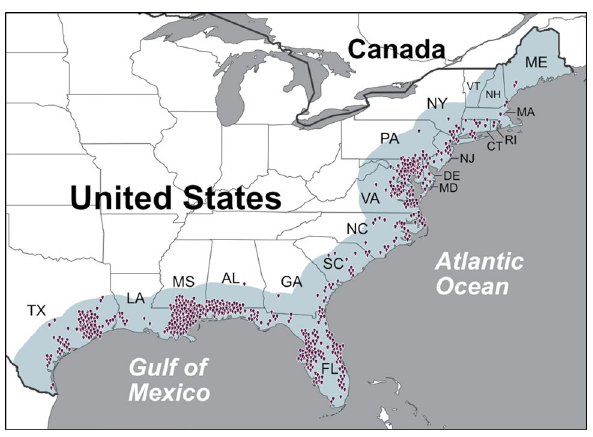
Figure 1. Original locations of the 709 confirmed non-foodborne V. vulnificus infections reported to the Cholera and Other Vibrio Illness Surveillance (COVIS) database between 2007 and 2018 within 200 km of the east USA coastline (blue